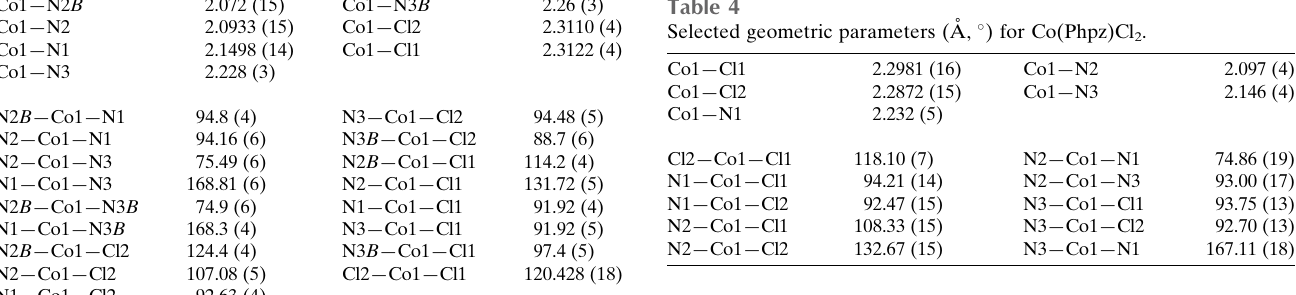
Table 2 Selected geometric parameters (A˚ , (cid:5) ) for Co(Pmhpz)Cl 2 . Co1—N2 B